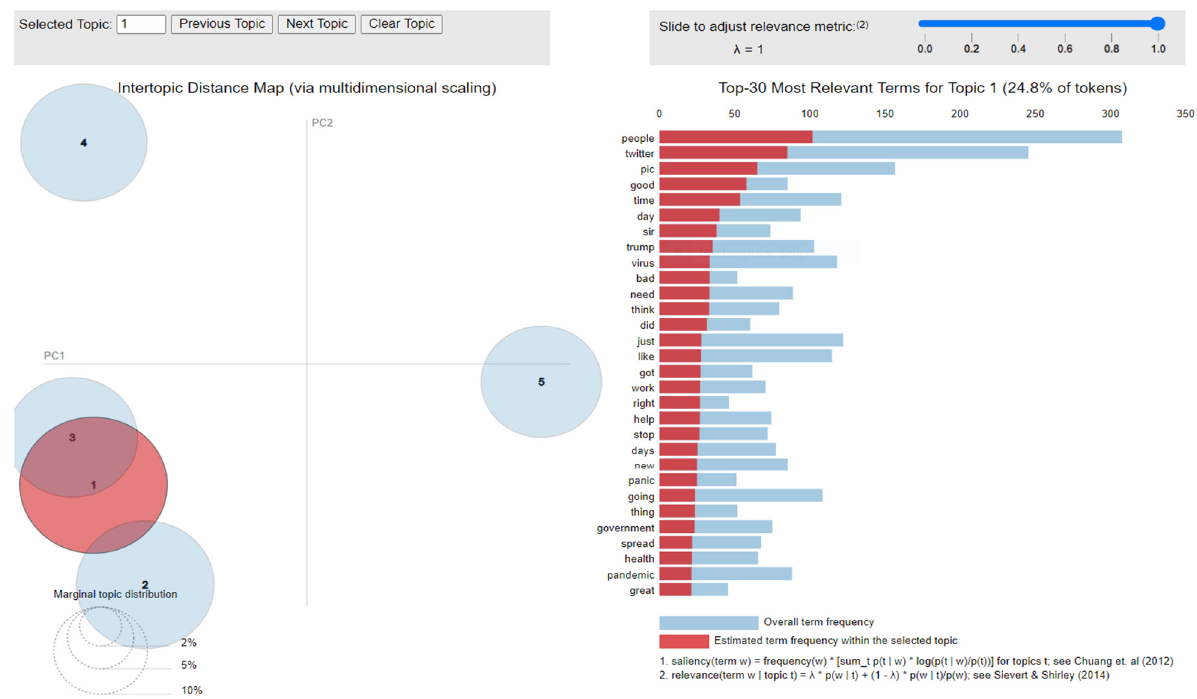
Figure 11. Inter-topic distance map for the mined dataset.